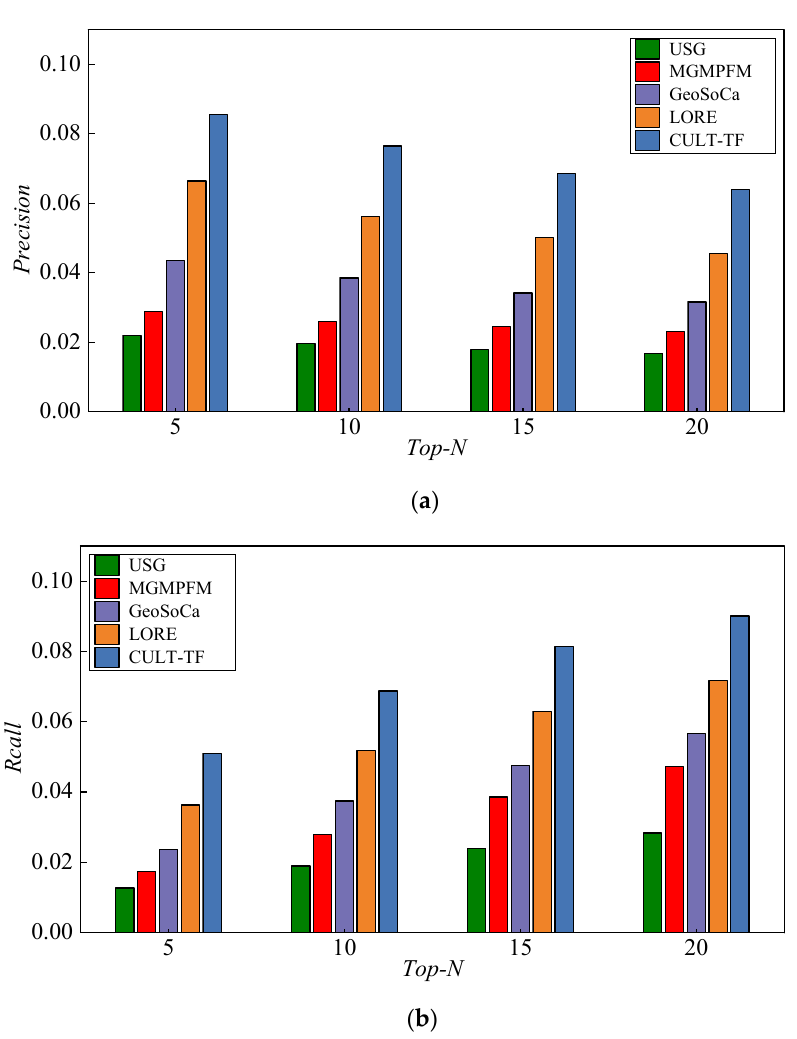
Figure 13. Recommendation accuracy of fi ve recommendation methods. ( a ) Top-N Precision; ( b ) Top-N Recall. Table 5. Precision and recall of di ff erent recommendation methods.